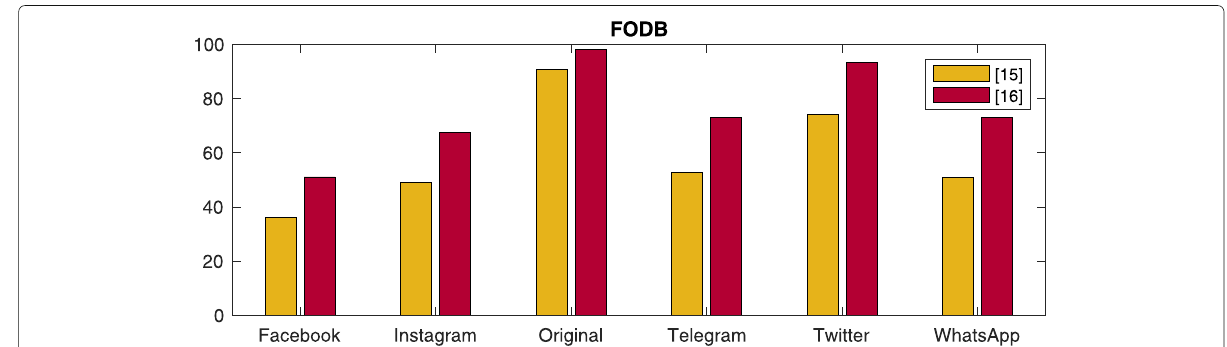
Fig. 2 Camera identification accuracies for the Forchheim Image Database as reported in [16]. Camera-native (original) images and five sharing platforms (Facebook, Instagram, Telegram, Twitter, Whatsapp) have been evaluated